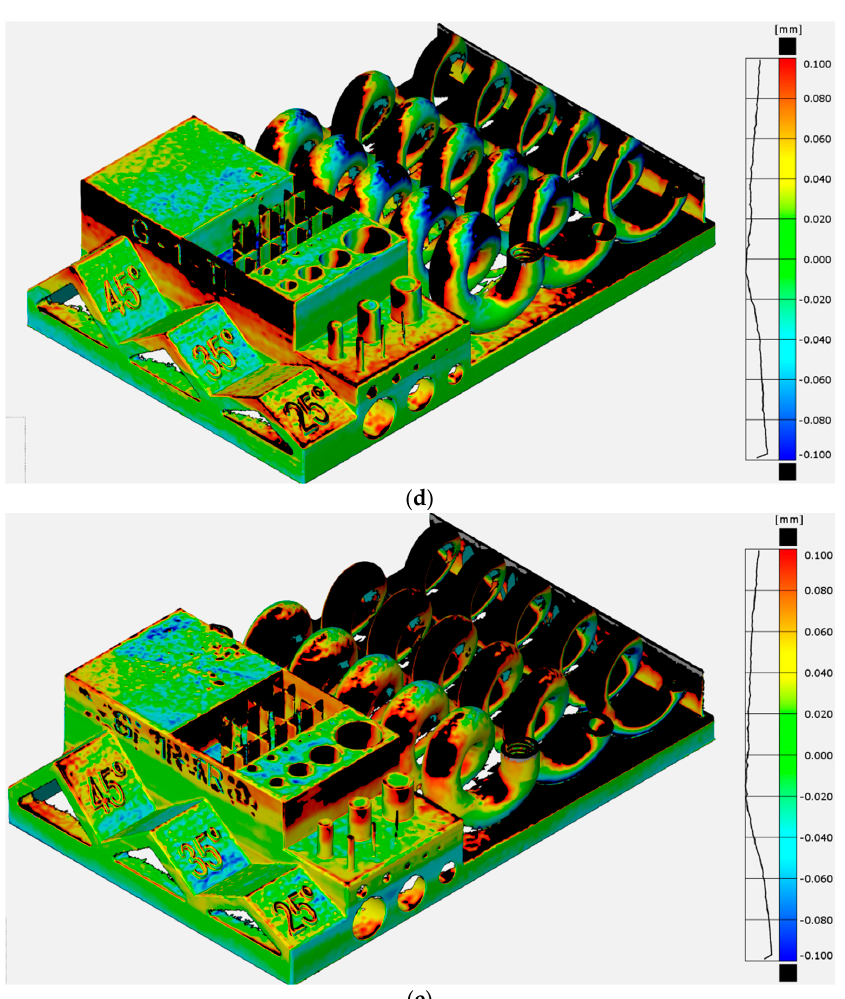
Figure 13. Color plot of the entire first job from G, 3D scanner top alignment. ( a ) BL, ( b ) BR, ( c ) C, ( d ) TL, ( e ) TR.